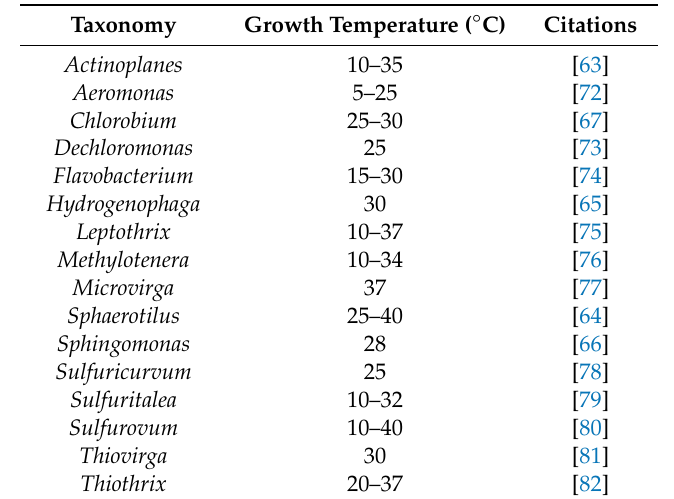
Table 3. Main bacterial genera identified in the P art , S1, and S2 samples. Growth temperatures of some of the species belonging to the di ff erent genera are